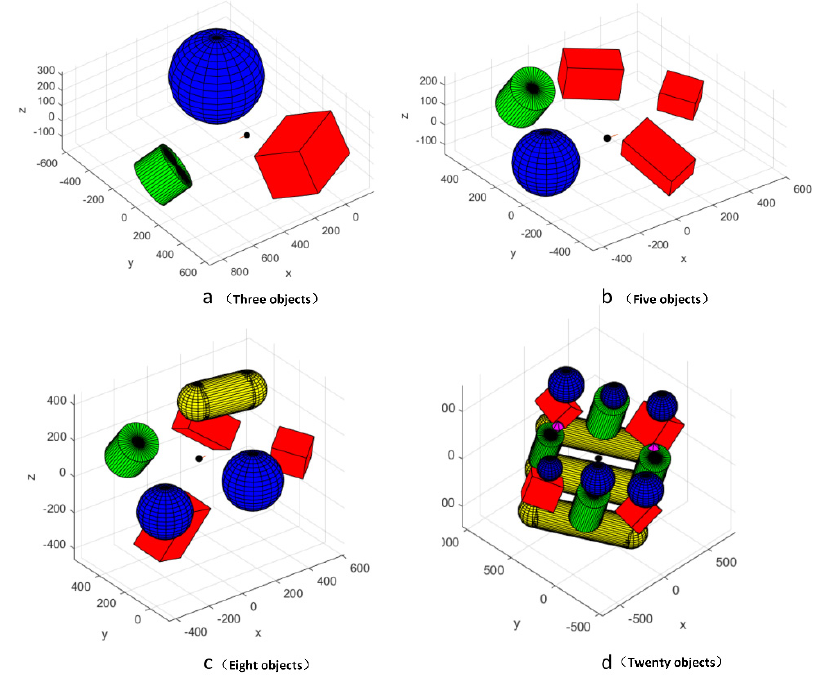
Figure 11. Scene 1 − Scene 4. Figure 11. Scene 1–Scene 4. Table 3. Necessary Geometric Characteristic Data of the Object in Scene Table 3. Necessary Geometric Characteristic Data of the Object in Scene 1.